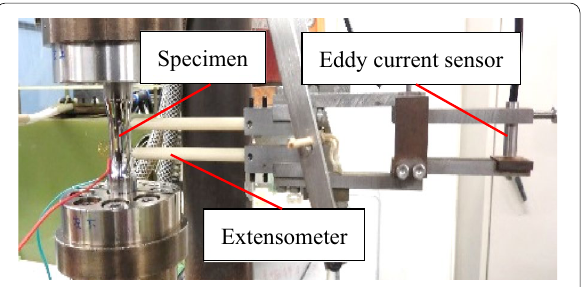
Figure 4 State of lever-type extensometer during fatigue